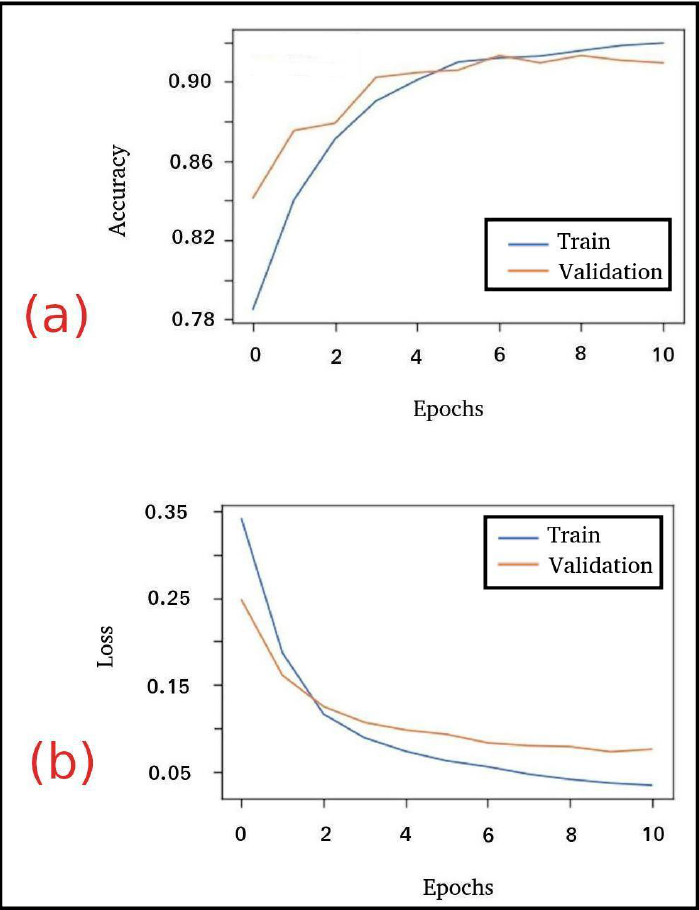
Figure 4. Accuracy metrics of the best performing model is shown in ( a ). The curves corresponding to the BCE loss function of the same model is presented in ( b ). The number of epochs is controlled by the early stopping switch activated during the neural network training